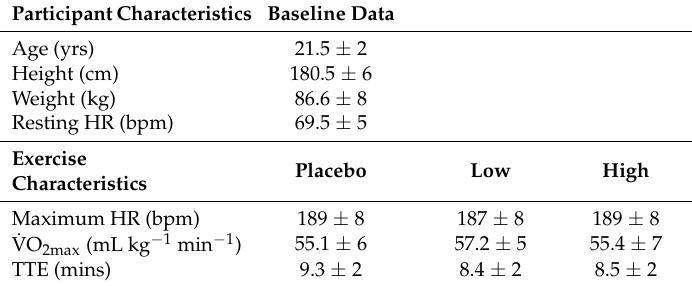
Table 1. Participant characteristics ( n = 10). All values are expressed as Mean ± Standard Deviation. Abbreviations: cm—centimetres; kg = kilograms; yrs—years; HR = heart rate; bpm = beats per minute, ˙VO 2max —maximum oxygen uptake; TTE = time to exhaustion; mins = minutes.